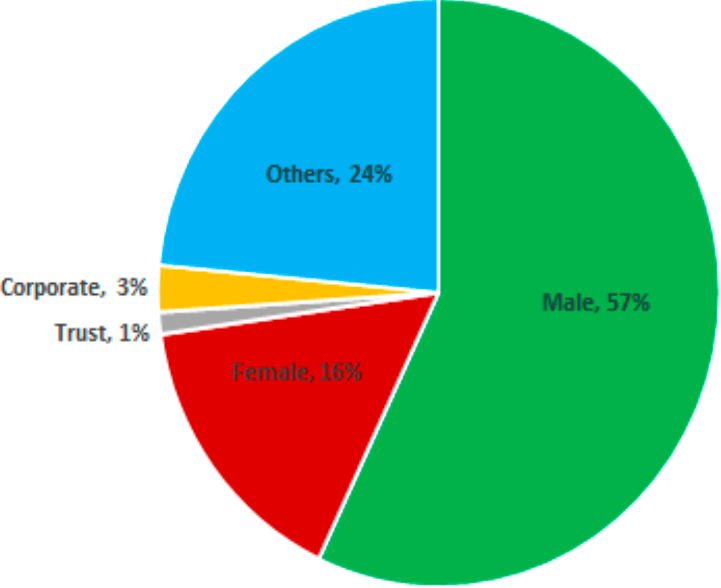
Figure 1. Percentage of Security Holders. Source: SPX (2020a).